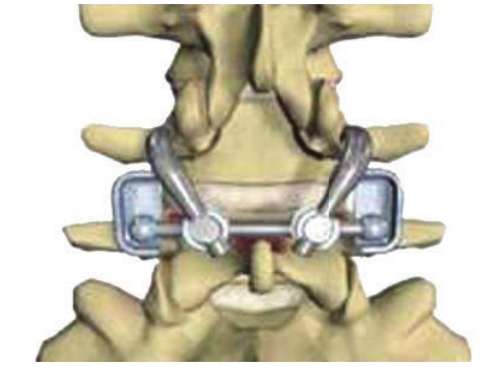
Figure 19: Total Facet Arthroplasty System.